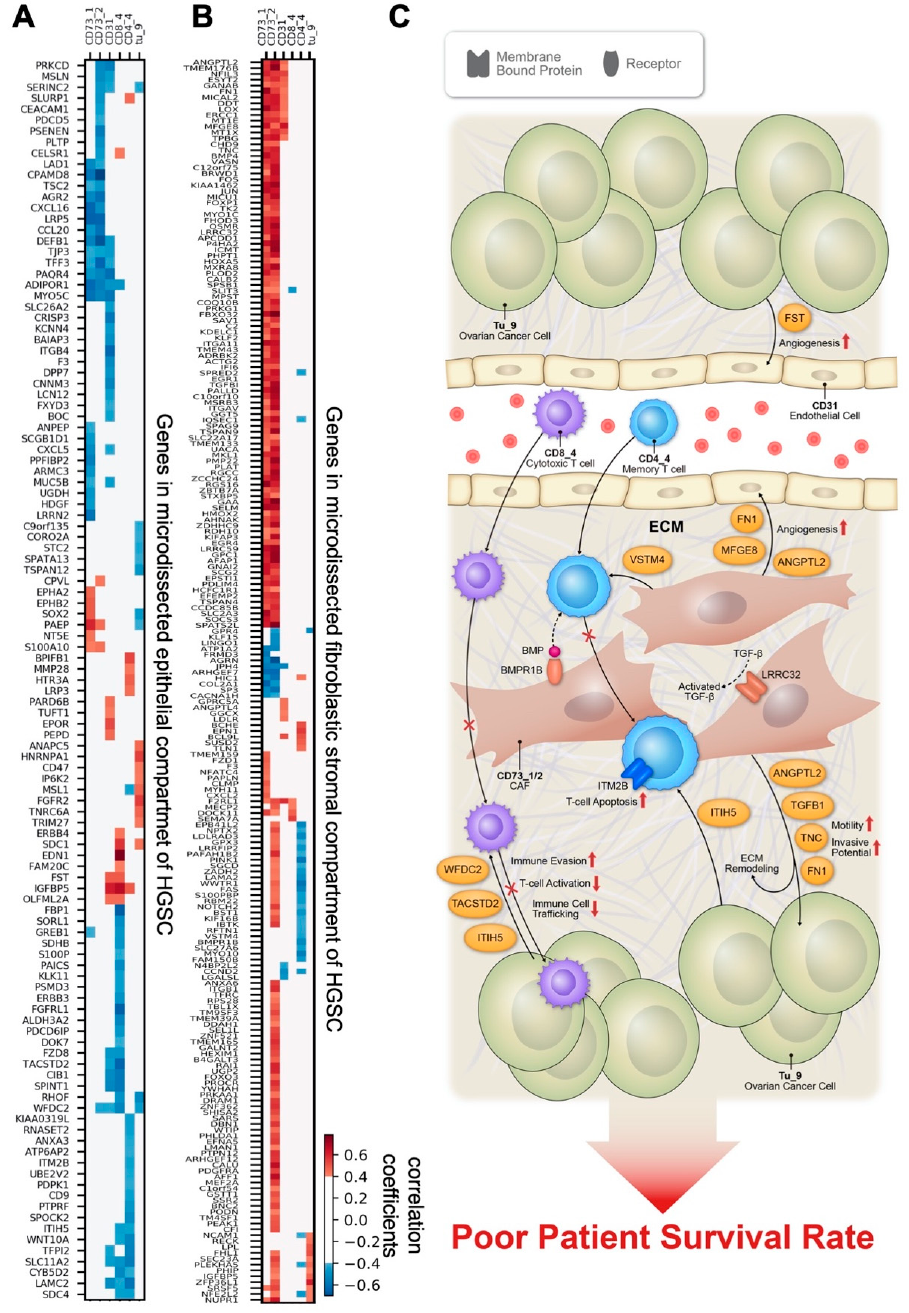
Figure 7. Gene correlation studies. Shown are correlations of gene expression in microdissected epithelial ( A ) and fibroblastic stromal ( B ) components of high-grade serous ovarian cancer (HSGC) samples with the imaging mass cytometry cell density in tumor-enriched regions ( n = 26 samples, Spearman correlation, p < 0.05). White color indicates absolute correlation coefficient ≤ 0.4 or p ≥ 0.05. Genes were ordered by hierarchical clustering with the Ward method. ( C ) Schematic summarizing the genes that are significantly correlated with prognostic IMC features to postulate the mechanisms by which these genes contribute to the prognostic features. Cancer cell-derived WFDC2, TACSTD2, and ITIH5 drive immune surveillance failure by compromising cytotoxic CD8+ T cells activity and infiltration. CAF-derived VSTM4 can reduce cytokine production by CD4 T cells and cause a decrease in T cell activation. CAFs expressing BMPR1B are more responsive to BMP signaling, which subsequently modulates the rigidity of CAFs, and reduces CD4_4 T cell trafficking. CAF-derived LRRC32 suppresses anticancer immune cell infiltration by modulating TGF- β signaling networks. ANGPTL2, TNC, TGFB1, FN1, BMPR1B, and LRRC32 promote tumor progression, angiogenesis, and ECM